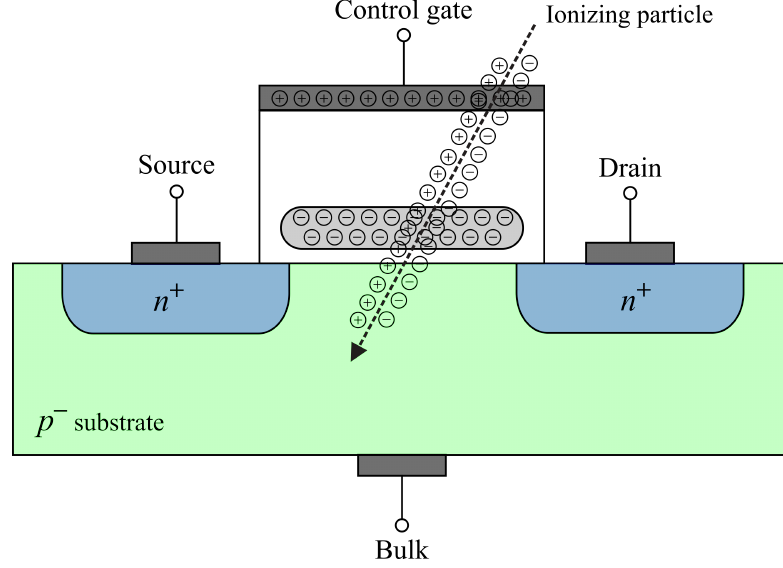
Figure 2. Floating-gate MOS transistor during irradiation.